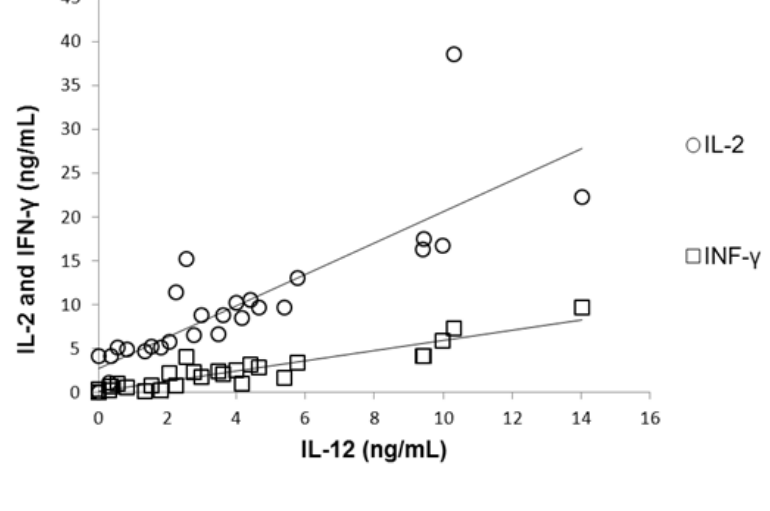
Figure 4. Correlation between plasmatic concentration of IL-12 and IL-2 ( r = 0.92; p < 0.01) and IFN-γ ( r = 0.89; p < 0.01). Malnourished children showed the lowest concentration of IL-12 and this was associated with diminished concentrations of IL-2 and